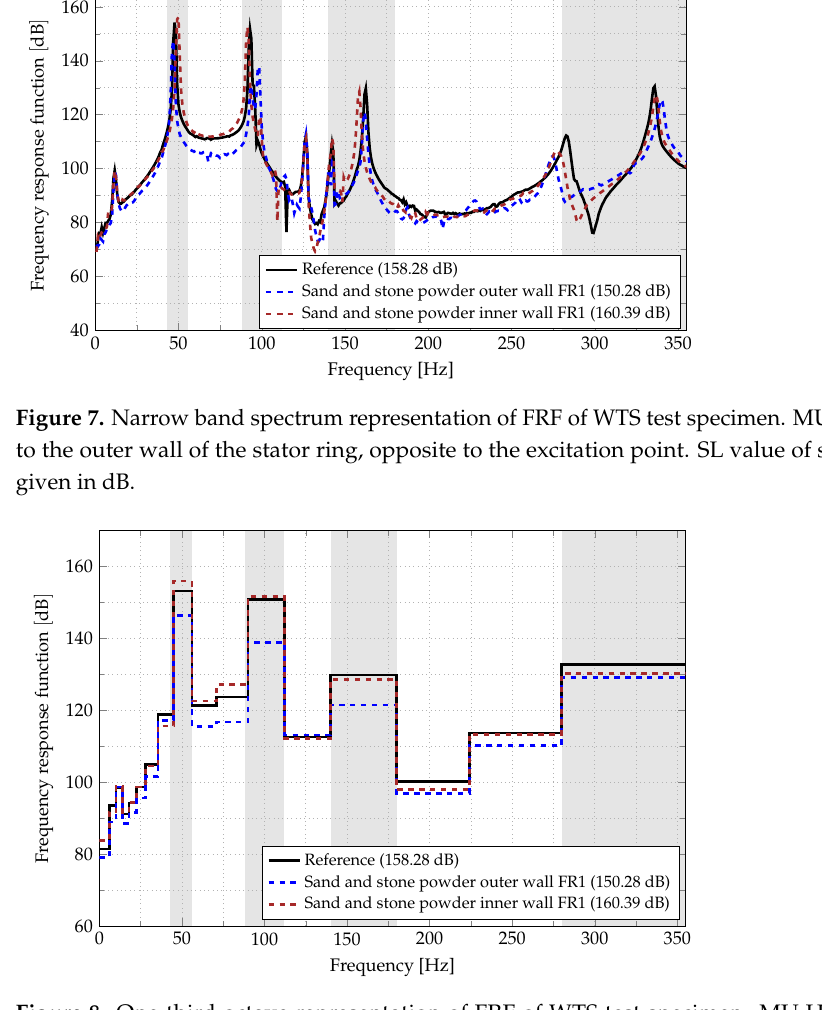
Figure 8. One-third octave representation of FRF of WTS test specimen. MU HCDP mounted to the outer wall of the stator ring, opposite to the excitation point. SL value of surface velocity is given in dB.